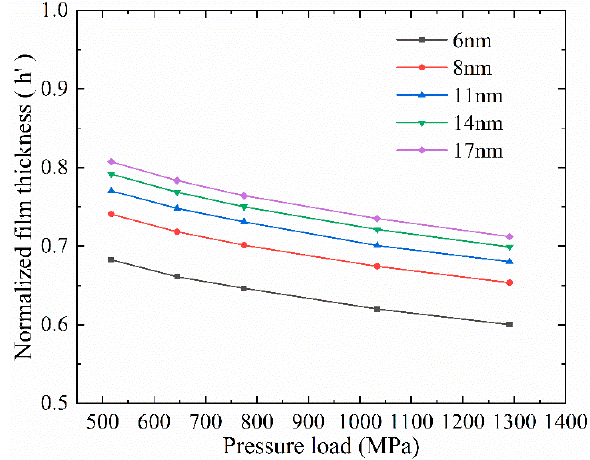
Figure 6. The dependence of film thickness on external pressure with different initial film thickness. 3.3. Density